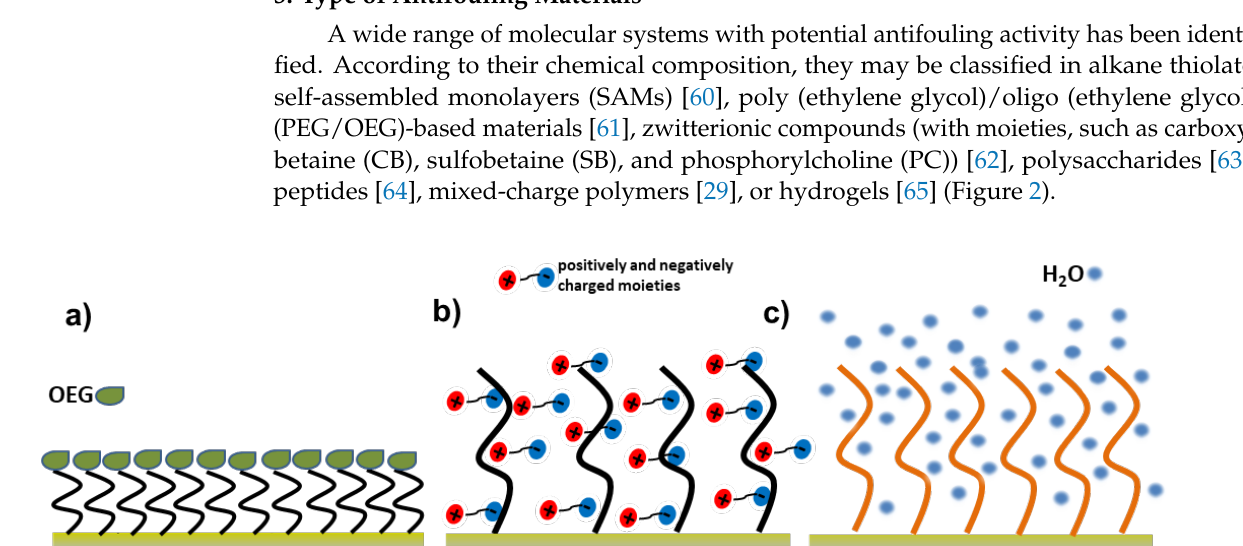
Figure 1. Schematic overview of the various approaches to fabricate antifouling surfaces for diagnostics and food safety.